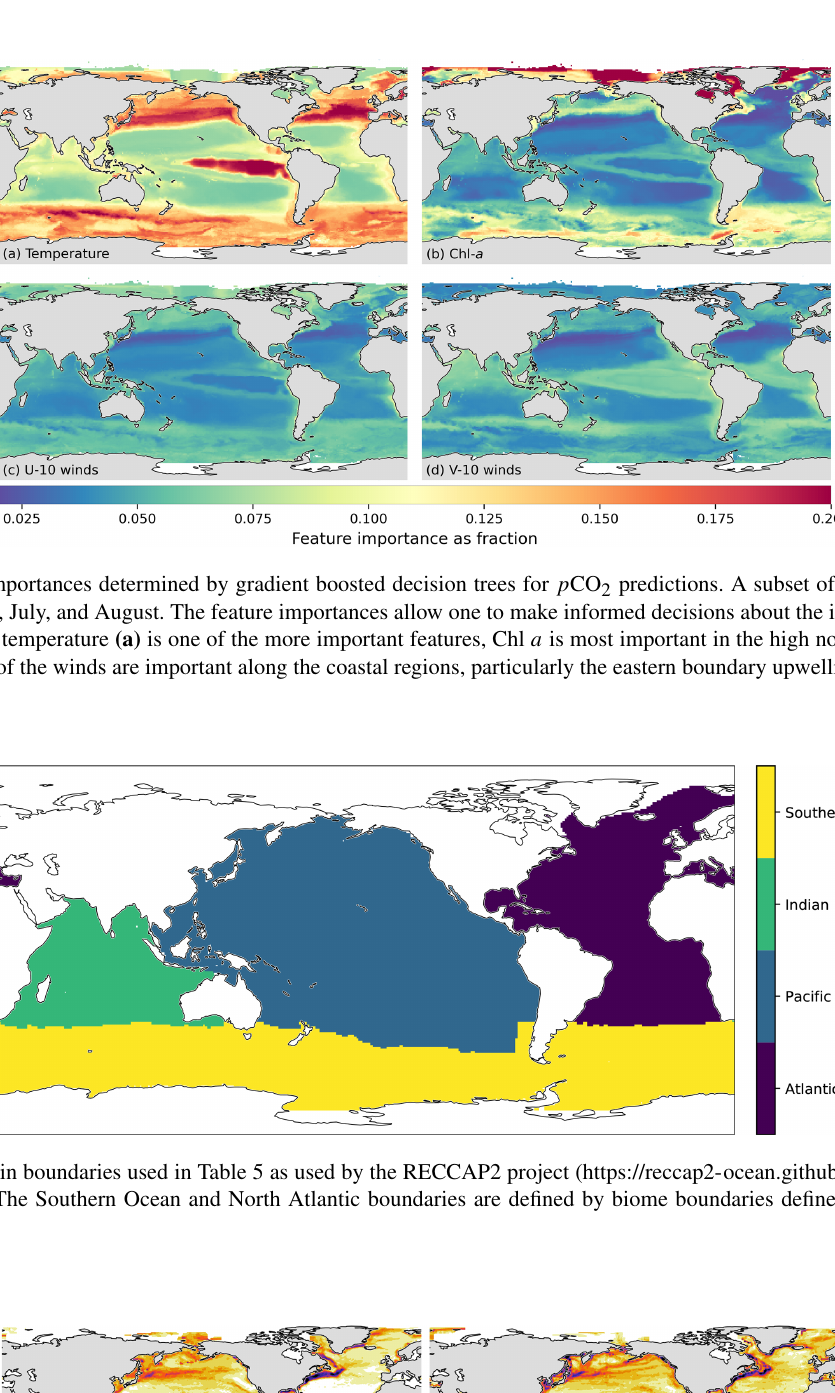
Earth Syst. Sci. Data, 13, 777–808, 2021